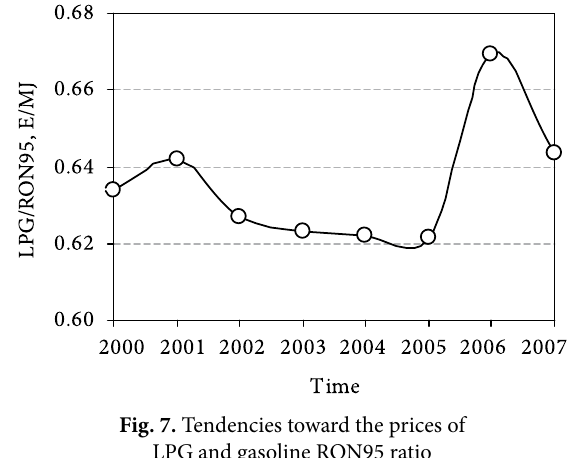
fig. 7. Tendencies toward the prices of LPG and gasoline RON95 ratio Table 4. The pay-off of LPG equipment